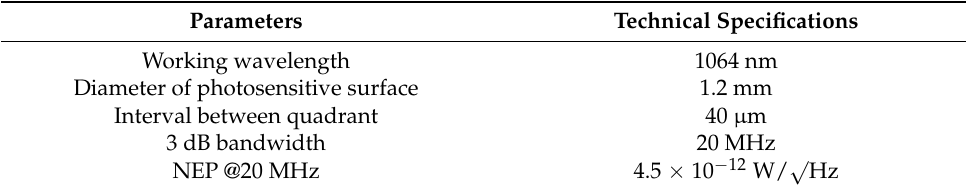
Table 3. Main parameters of the GD4542-20M QPD.